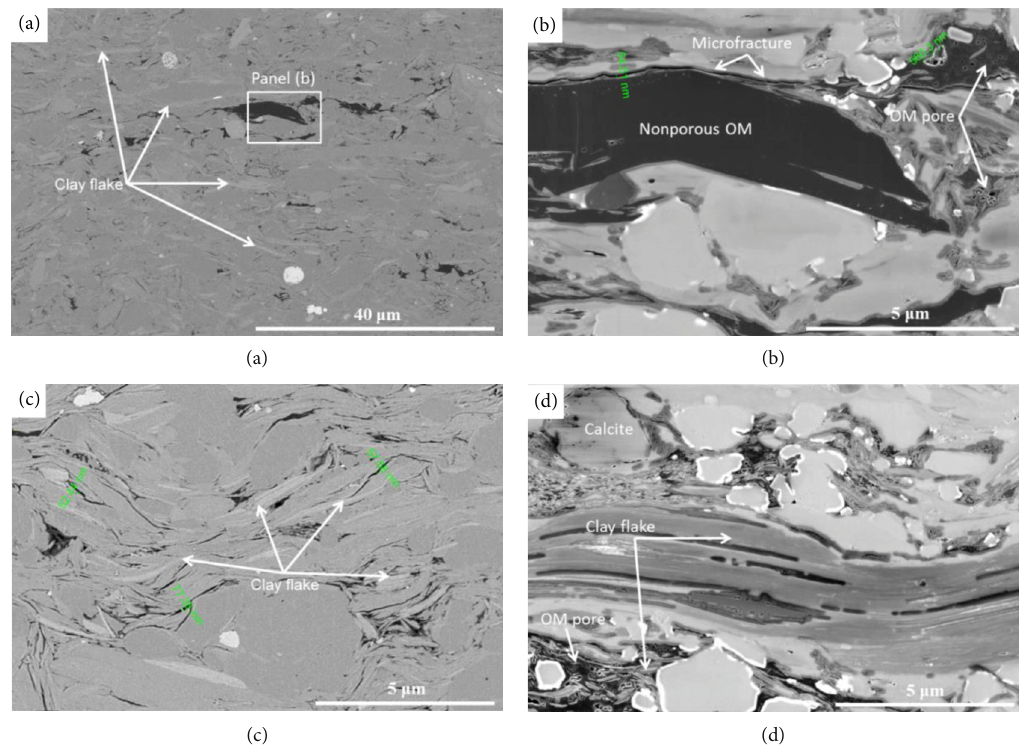
Figure 9: FE-SEM images of silica-rich argillaceous shales (CM). (a) Back-scattered electron of silica-rich argillaceous shales. Abundant clay fl akes are commonly oriented along the lamination. (b) Nonporous organic matter particles in silica-rich argillaceous shale. There is microfracture between organic matter particle and framework minerals. (c) Intraparticle pores are observed in clay fl akes. (d) Pores in oriented kerogen-clay